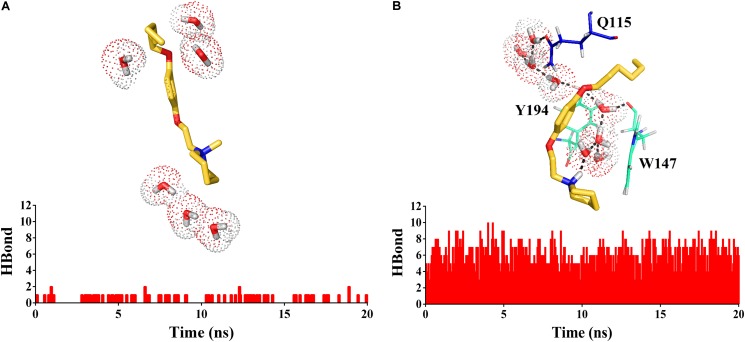
Histogram of hydrogen bonds during the molecular dynamics simulation for 12a
(A) and 11a
(B). In (B) the hydrogen bonds network is represented with dashed lines.